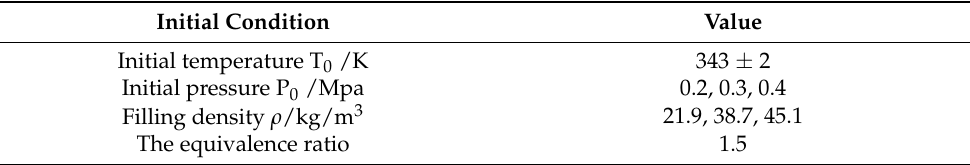
Table 2. Experimental initial